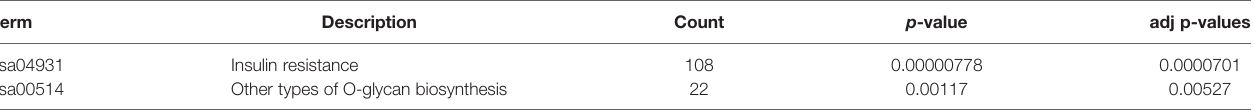
TABLE 2 | KEGG pathway analysis of OGT/OGA related pathways with ovarian cancer.